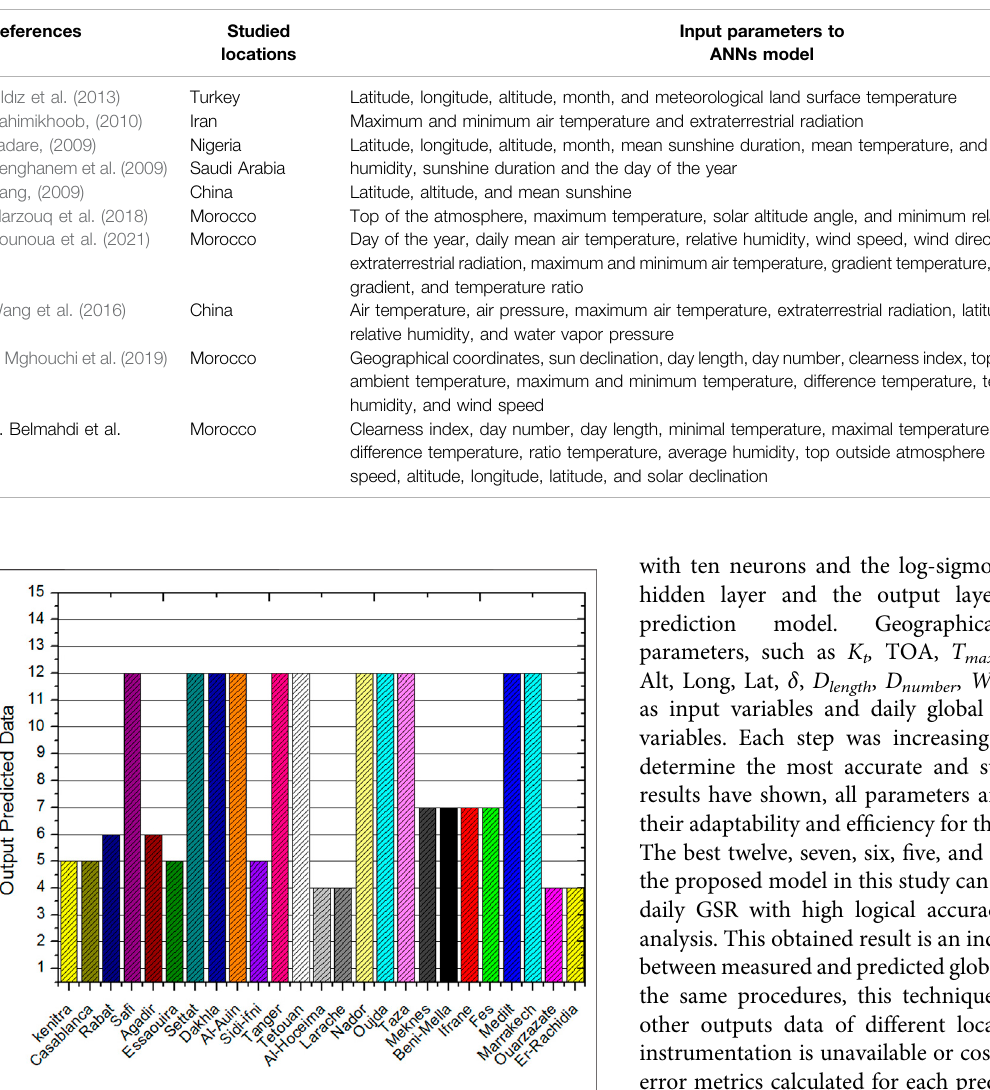
TABLE.6 | Metrics comparison of current study with the existing literature studies in the prediction of daily global solar radiation.